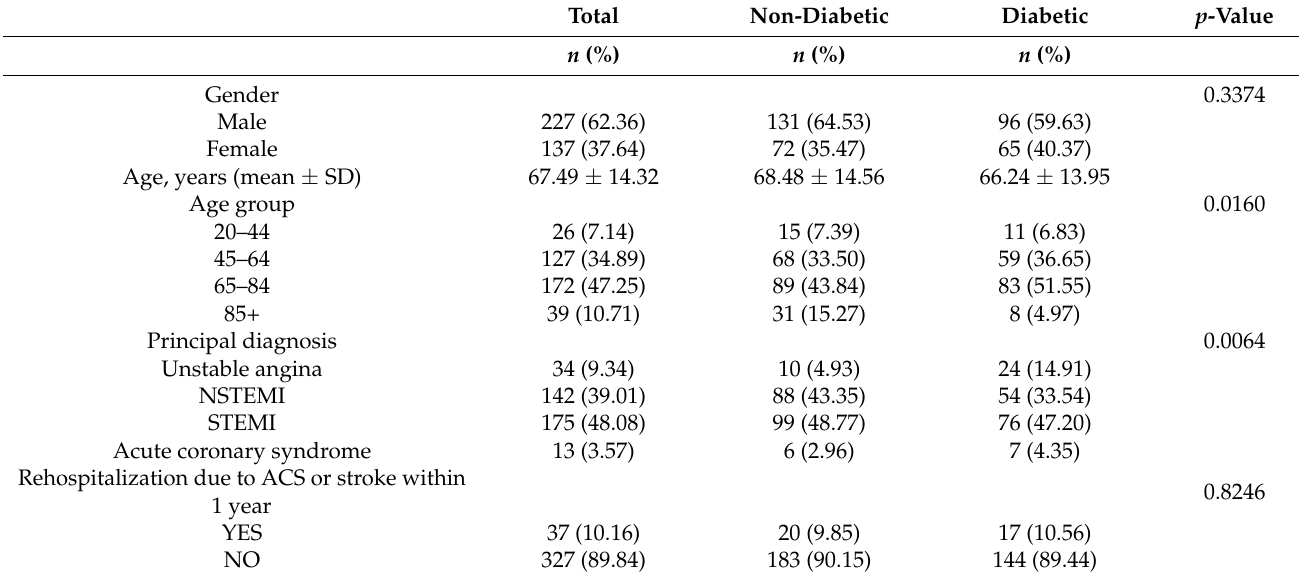
Table 1. Characteristics among inpatients.